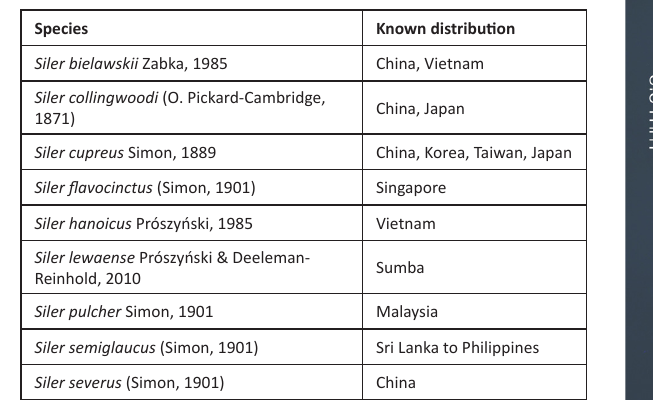
Table 1. Distribution of Siler